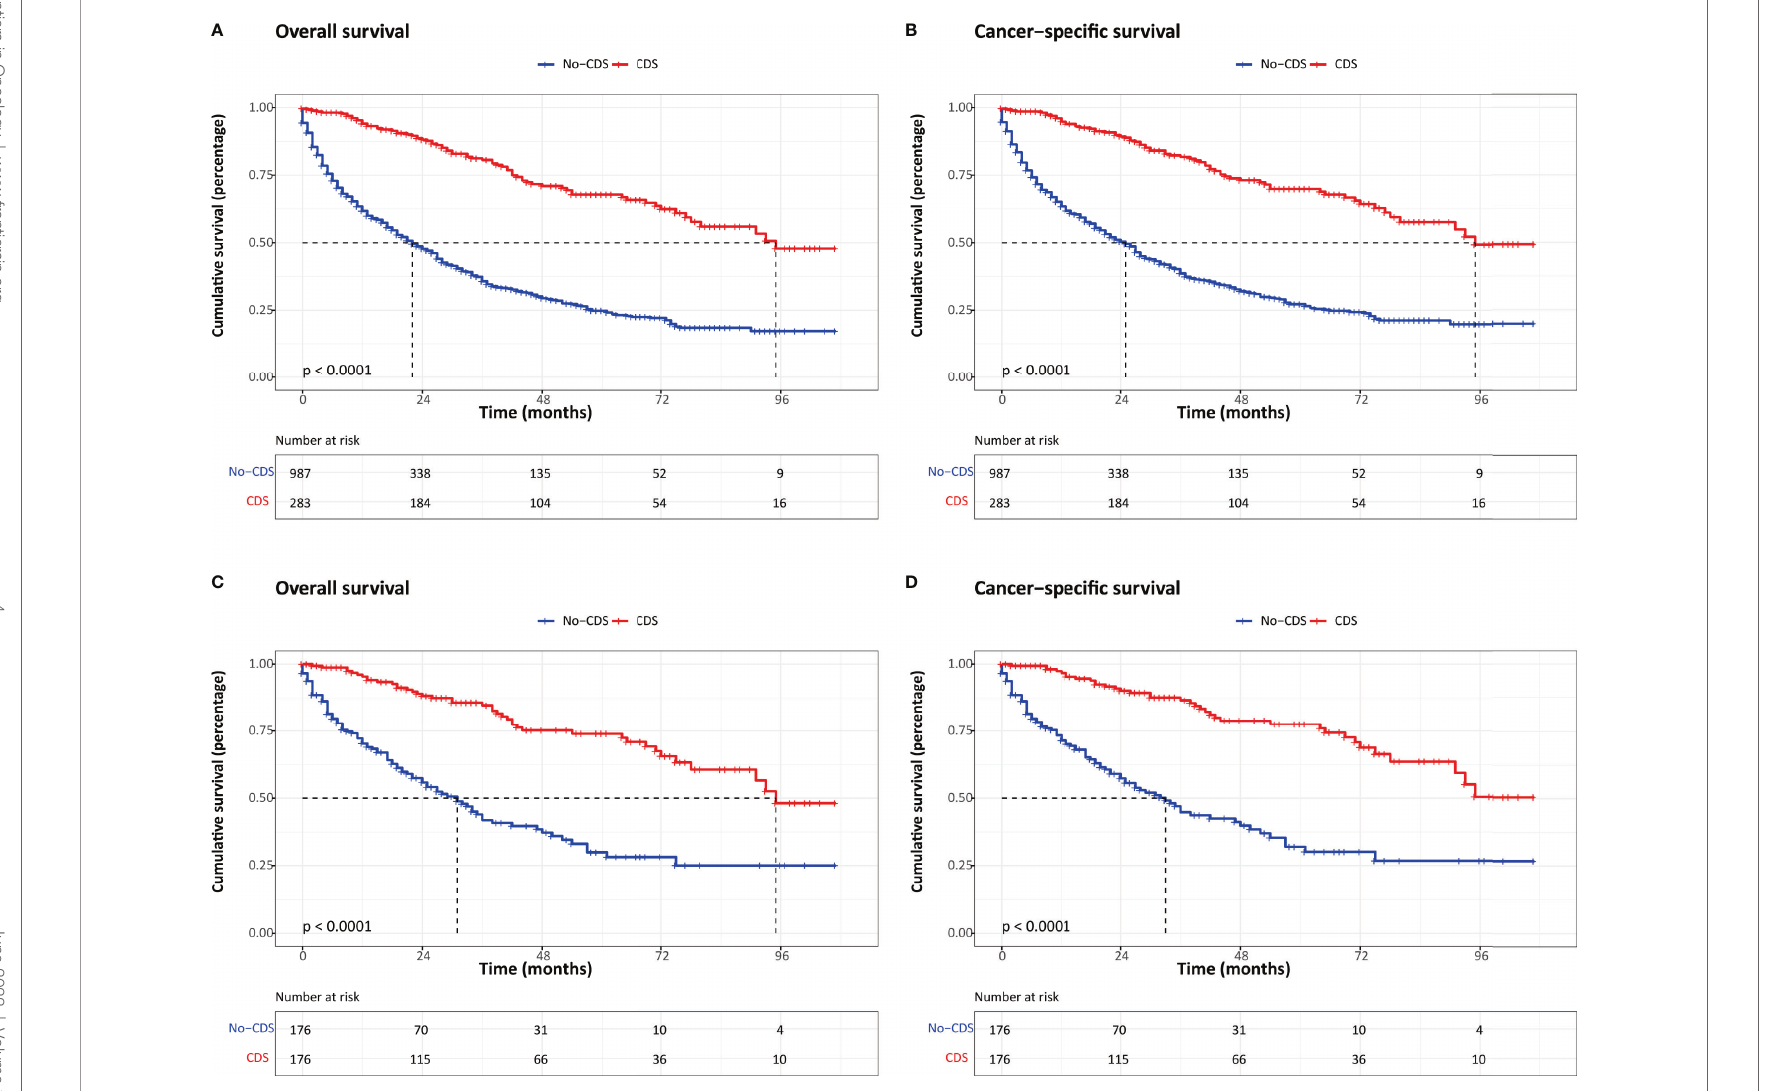
FIGURE 1 | Kaplan – Meier survival estimates for patients in CDS and No-CDS groups: (A) overall survival before PSM. (B) Cancer-speci fi c survival before PSM. (C) Overall survival after PSM. (D) Cancer-speci fi c survival after PSM. CDS, cancer-directed